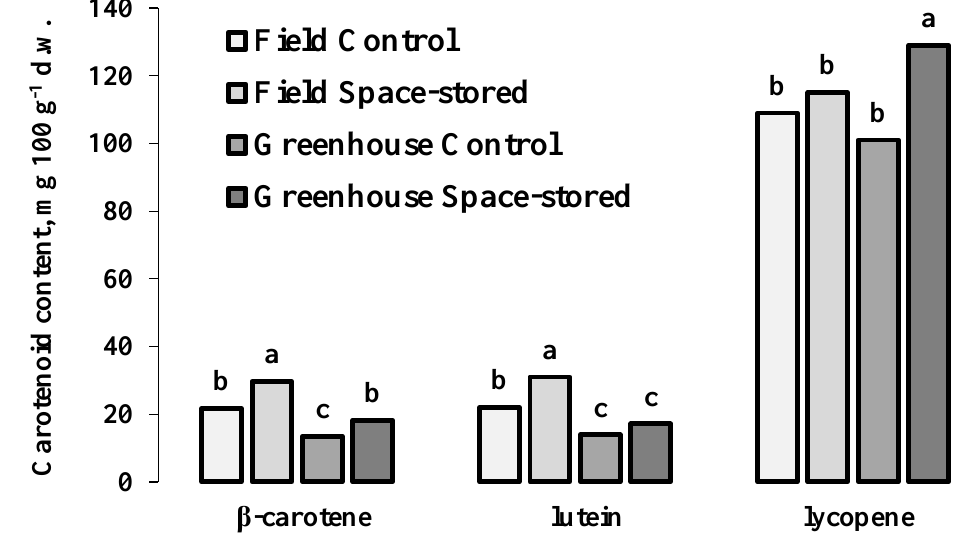
Figure 3. Carotenoid profile of tomato fruits obtained from control plants and plants derived from space-stored seeds grown in open field and in greenhouse. For each carotenoid, values with the same letters do not differ statistically according to Duncan test at p < 0.05.